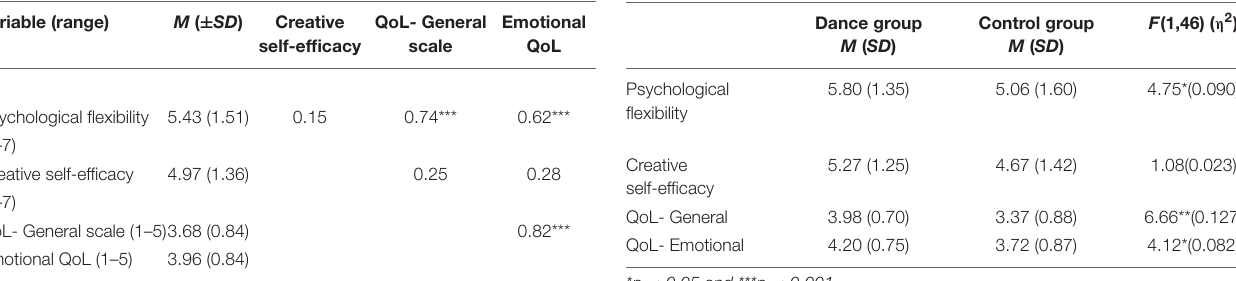
TABLE 3 | Means, standard deviations and F values of the study variables, by group N =